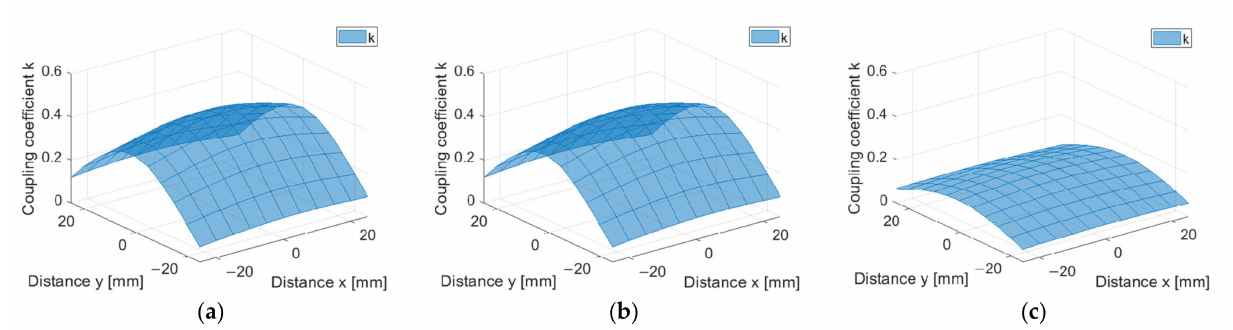
Figure 9. Single DD x - y plane coupling coefficient measurements: ( a ) 15.3 mm distance between the pads; ( b ) 25.3 mm distance between the pads; ( c ) 35.3 mm distance between the pads.